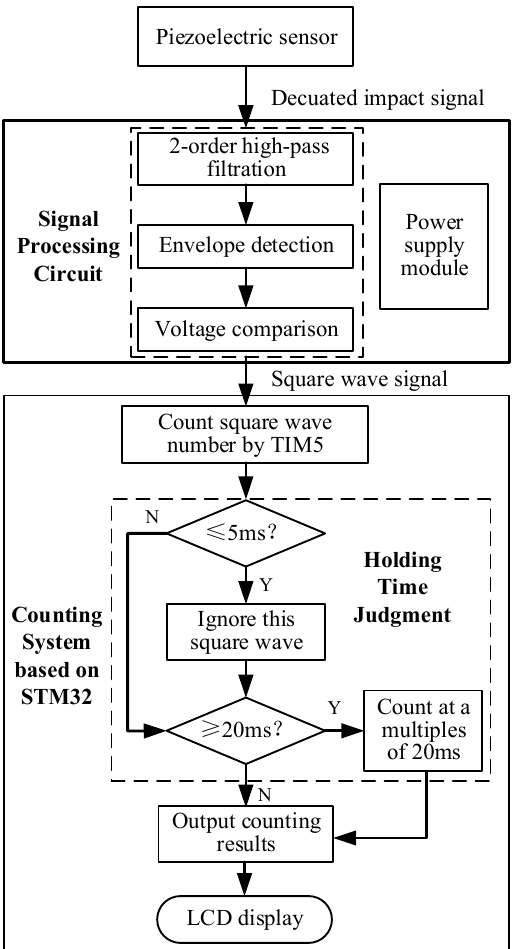
Figure 13. The schematic diagram of losing corn kernel recognition and counting system.